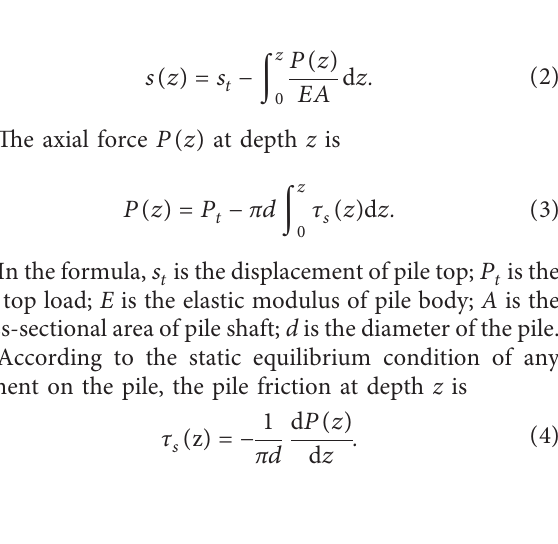
Figure 9: The calculation model of single pile by load transfer method.